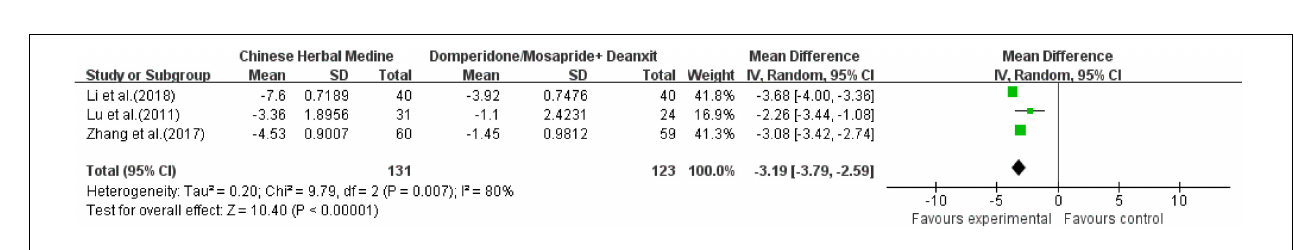
FIGURE 9 | Meta-analysis of HAMA score of CHM vs. western medicine group.